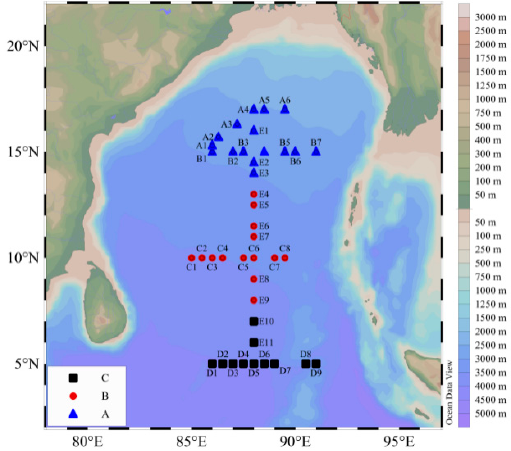
Figure 1. Maps of the study area, and the distribution of the sampling stations (blue triangle was sub-region A in the northern part of the Bay of Bengal, red round was sub-region B in the central part of the Bay of Bengal, and black square was sub-region C in the southern part of the Bay of